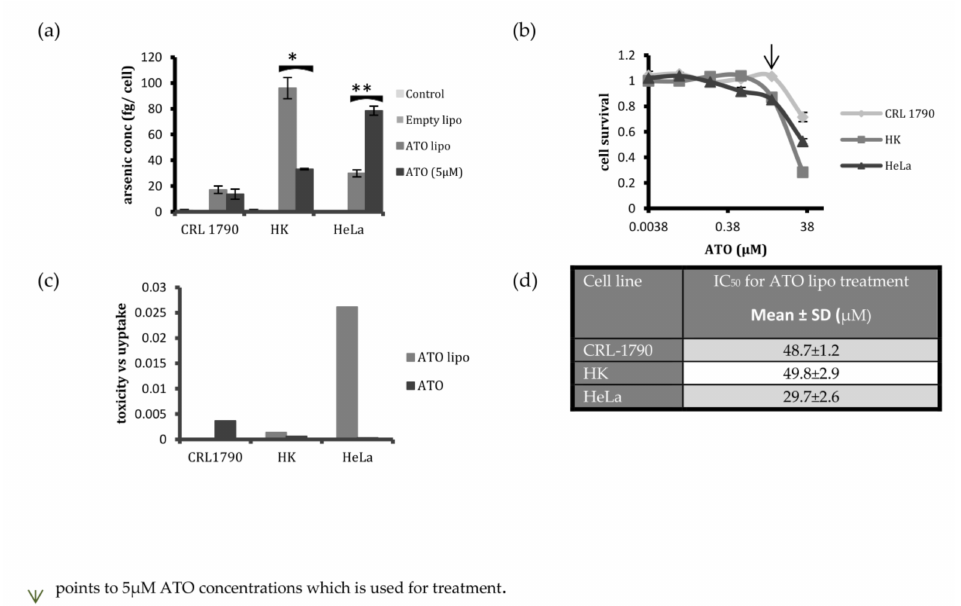
Figure 6. Arsenic uptake and toxic response in the control cells and HeLa cells. ( a ) A comparative study of arsenic concentration per cell in CRL-1790, human epidermal keratinocyte (HK), and HeLa—as determined via ICP-MS after 24 h of treatment with media, control liposomes, ATO lipo, and free ATO; ( b ) Cell survival following the exposure of cervical cancer and control cell lines to ATO lipo for 24 h—assessed using the MTT assay; ( c ) Toxicity–uptake ratio of ATO lipo and free ATO in HeLa cells compared to control cell lines, after treatment for 24 h. ATO lipo is effective in generating toxicity in HeLa cells, while having a non-toxic effect on the normal cells; ( d ) The IC 50 values for three cell lines following 24 h of ATO liposomal treatment. Data are displayed as mean ± SD from three replicates; * p < 0.05, ** p <